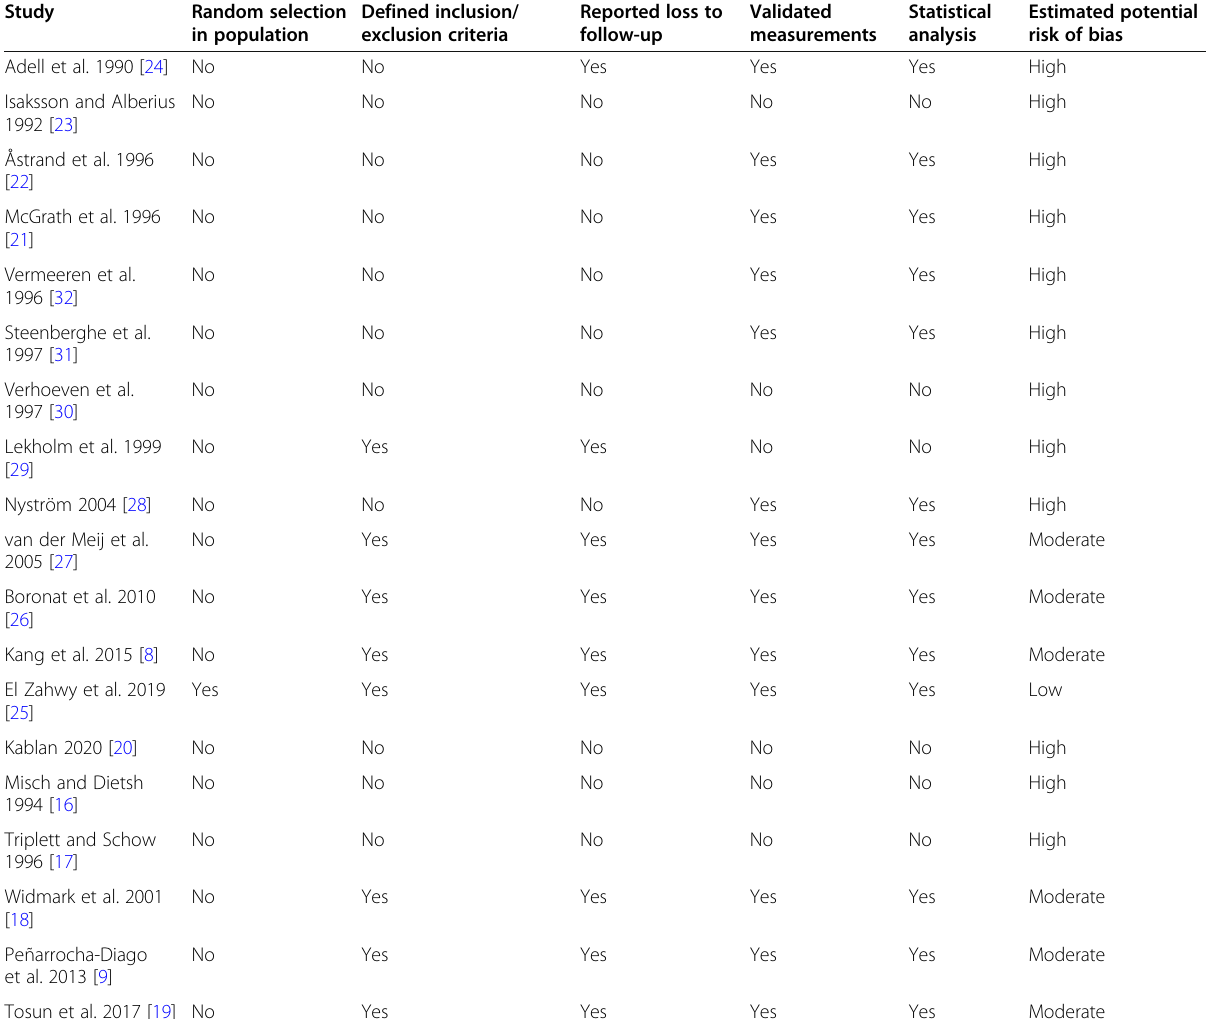
Table 4 Quality assessment of included studies